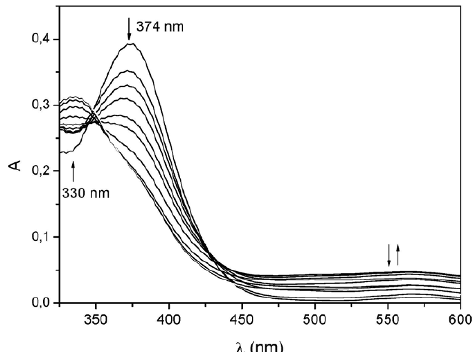
Figure 3. Time-resolved spectra of 15 µM quercetin taken 0, 0.2, 0.6, 1, 1.6, 2, 3, 5, 7, and 9 seconds after mixing with 100 µM peroxynitrite at pH 6.0.